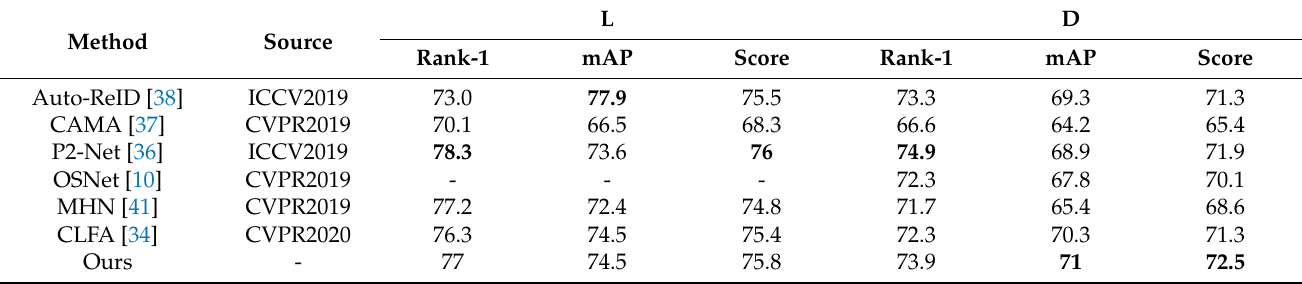
Table 4. Comparison of different methods on